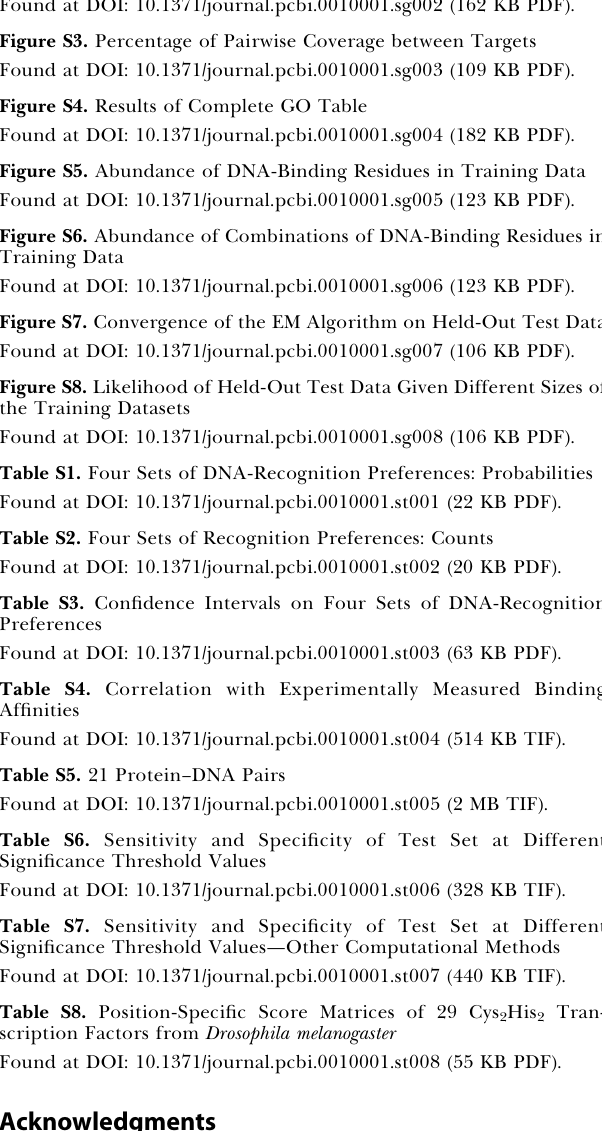
Figure S1. Sequence logos of 29 Drosophila Transcription Factors Found at DOI: 10.1371/journal.pcbi.0010001.sg001 (617 KB PDF). Figure S2. Number of Predicted Direct Targets Found at DOI: 10.1371/journal.pcbi.0010001.sg002 (162 KB PDF). Figure S3. Percentage of Pairwise Coverage between Targets Found at DOI: 10.1371/journal.pcbi.0010001.sg003 (109 KB PDF). Figure S4. Results of Complete GO Table Found at DOI: 10.1371/journal.pcbi.0010001.sg004 (182 KB PDF). Figure S5. Abundance of DNA-Binding Residues in Training Data Found at DOI: 10.1371/journal.pcbi.0010001.sg005 (123 KB PDF). Figure S6. Abundance of Combinations of DNA-Binding Residues in Training Data Found at DOI: 10.1371/journal.pcbi.0010001.sg006 (123 KB PDF). Figure S7. Convergence of the EM Algorithm on Held-Out Test Data Found at DOI: 10.1371/journal.pcbi.0010001.sg007 (106 KB PDF). Figure S8. Likelihood of Held-Out Test Data Given Different Sizes of the Training Datasets Found at DOI: 10.1371/journal.pcbi.0010001.sg008 (106 KB PDF). Table S1. Four Sets of DNA-Recognition Preferences: Probabilities Table S2. Four Sets of Recognition Preferences: Counts Table S3. Confidence Intervals on Four Sets of DNA-Recognition Preferences Table S4. Correlation with Experimentally Measured Binding Affinities Table S5. 21 Protein–DNA Pairs Table S6. Sensitivity and Specificity of Test Set at Different Significance Threshold Values Table S7. Sensitivity and Specificity of Test Set at Different Significance Threshold Values—Other Computational Methods Table S8. Position-Specific Score Matrices of 29 Cys 2 His 2 Tran- scription Factors from Drosophila